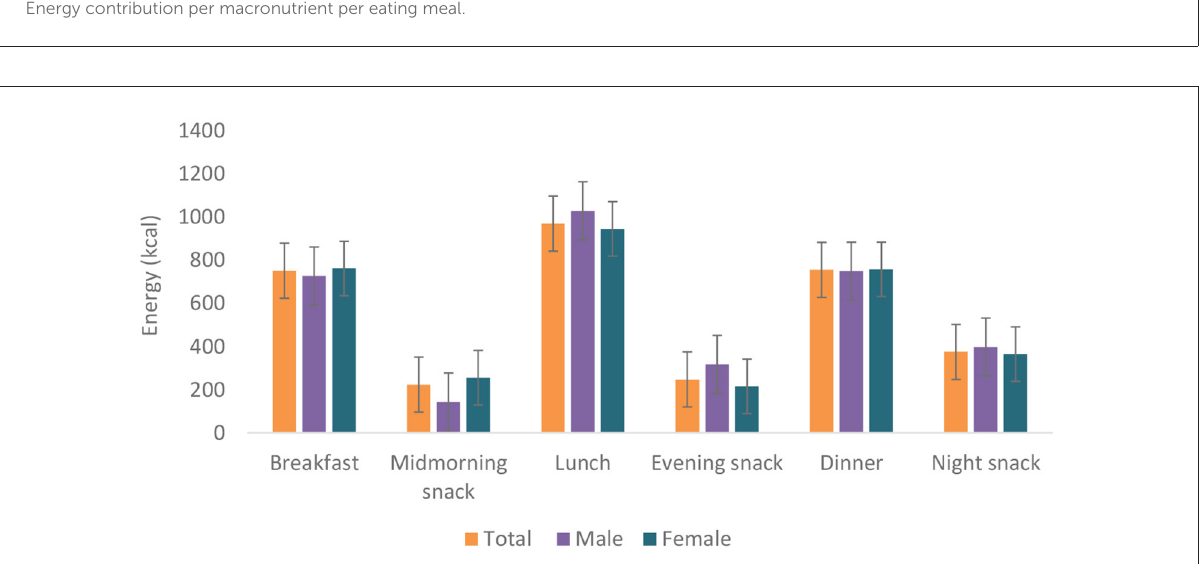
FIGURE2 Energy contribution per macronutrient per eating meal.